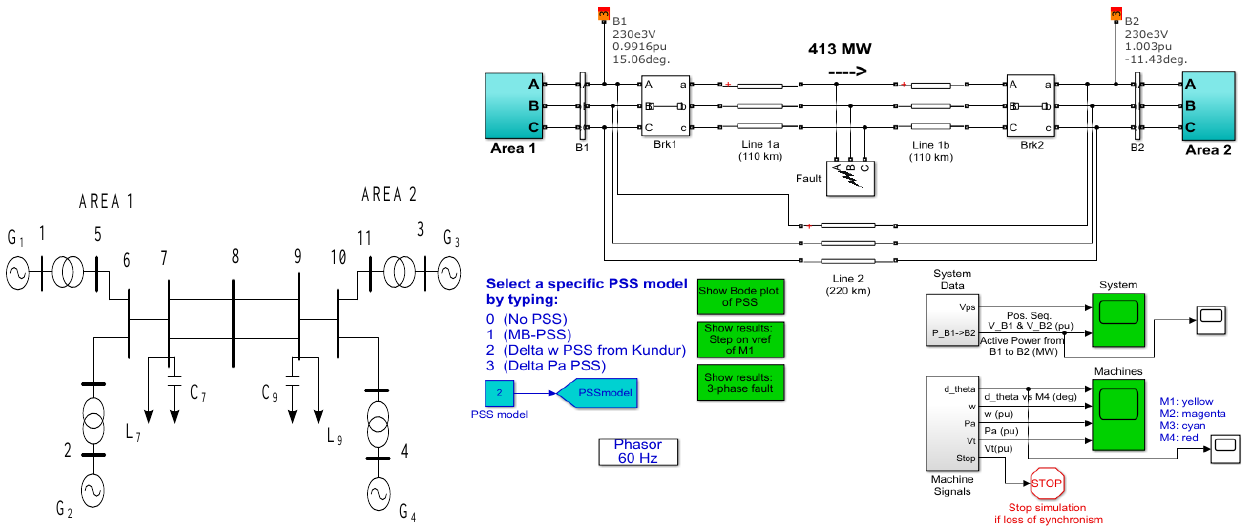
Figure 6. IEEE 4 − machine 2 − area system ( a ) structural diagram; ( b ) Simulink model.